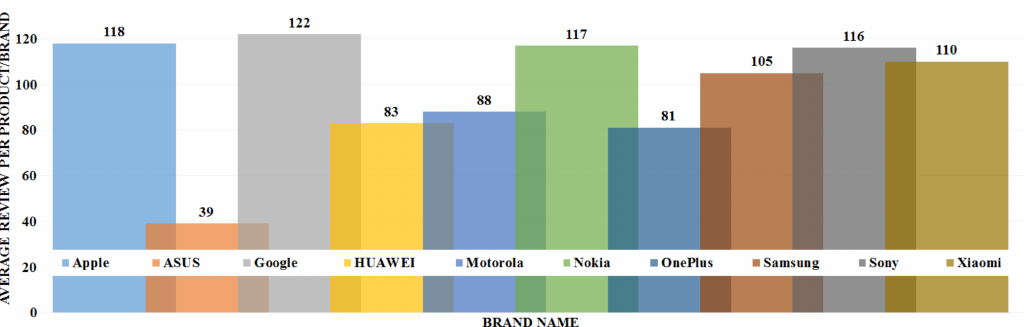
Figure 5. Average number of reviews per product per brand.